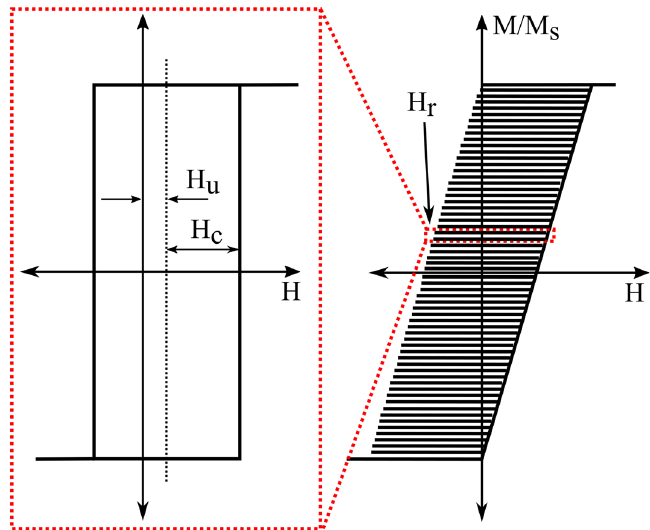
Figure 1. A schematic FORC measurement with interacting hysterons according to the Preisach model. The inset is a schematic of an individual hysteron, which switches down at the reversal field H r